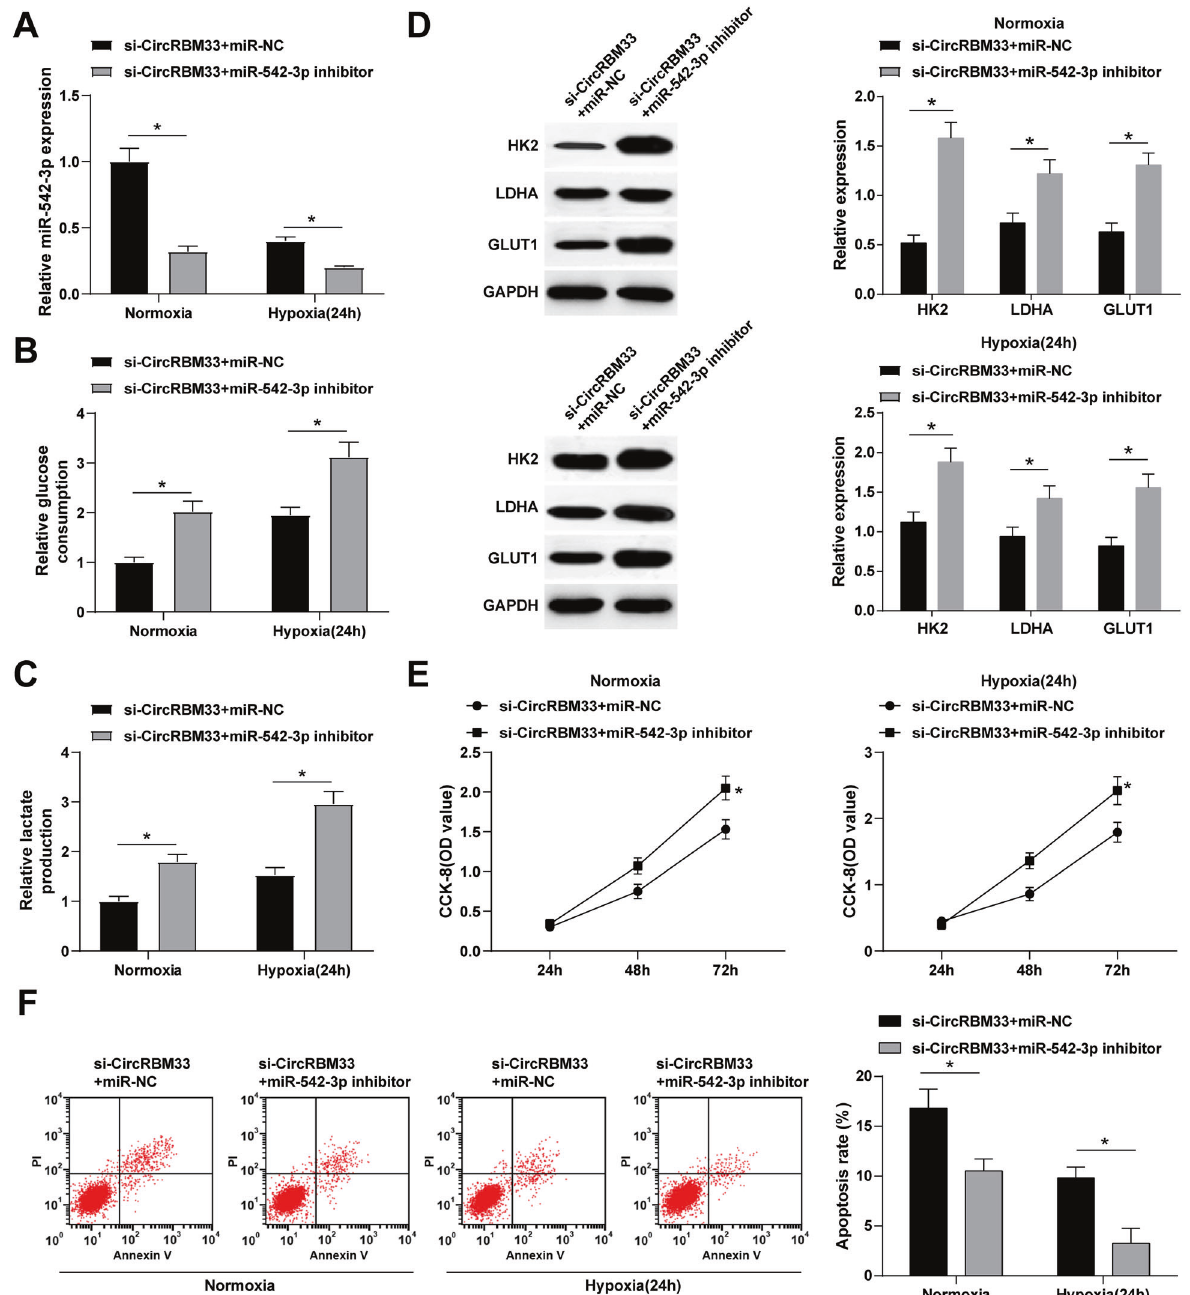
Fig. 5 Inhibition of miR-542-3p rescues circRBM33 knockout-mediated glycolysis and apoptosis for BCa cells. A miR-542-3p expression in MCF-7 cells after inhibiting circRBM33 and miR-542-3p; B Glucose consumption in MCF-7 cells after inhibiting circRBM33 and miR-542-3p; C Lactate production in MCF-7 cells after inhibiting circRBM33 and miR-542-3p; D Western blot detected HK2, LDHA and GLUT1 expression in MCF-7 cells after inhibiting circRBM33 and miR-542-3p; E CCK-8 detected MCF-7 cell proliferation after inhibiting circRBM33 and miR-542-3p; F Flow cytometry detected MCF-7 cell apoptosis after inhibiting circRBM33 and miR-542-3p (Under normoxia, the apoptotic rate dropped from 16.82% to 10.52% after inhibiting circRBM33 and miR-542-3p; Under hypoxia, the apoptotic rate decreased from 9.80% to 3.25% after inhibiting circRBM33 and miR-542-3p); * P < 0.05. Data were expressed in the form of mean ± standard deviation (Repetitions = 3). The comparison between two groups should be performed by t test. apoptosis of BCa cells in the normoxia and hypoxia groups, and mimic inhibits glycolysis and proliferation of BCa cells in the that such effects can be mitigated when HIF-1 α was over- normoxia and hypoxia groups, while the co-transfection of HIF-1 α expressed (Fig. 7G). Together, these results demonstrate that miR- reverses the effects of miR-542-3p mimic on glycolysis and 542-3p inhibits glycolysis and proliferation and promotes cell proliferation (Fig. 7C – F). According to the fl ow cytometry results, apoptosis of BCa cells through HIF-1 α . we found that the overexpression of miR-542-3p promotes the